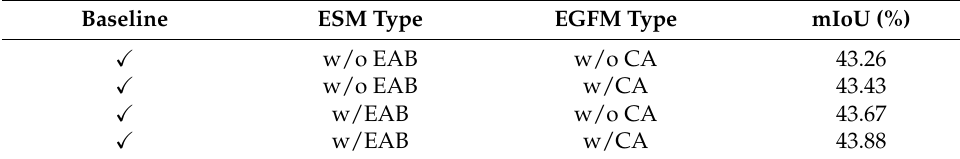
Table 4. Results of the effect of attention module on segmentation